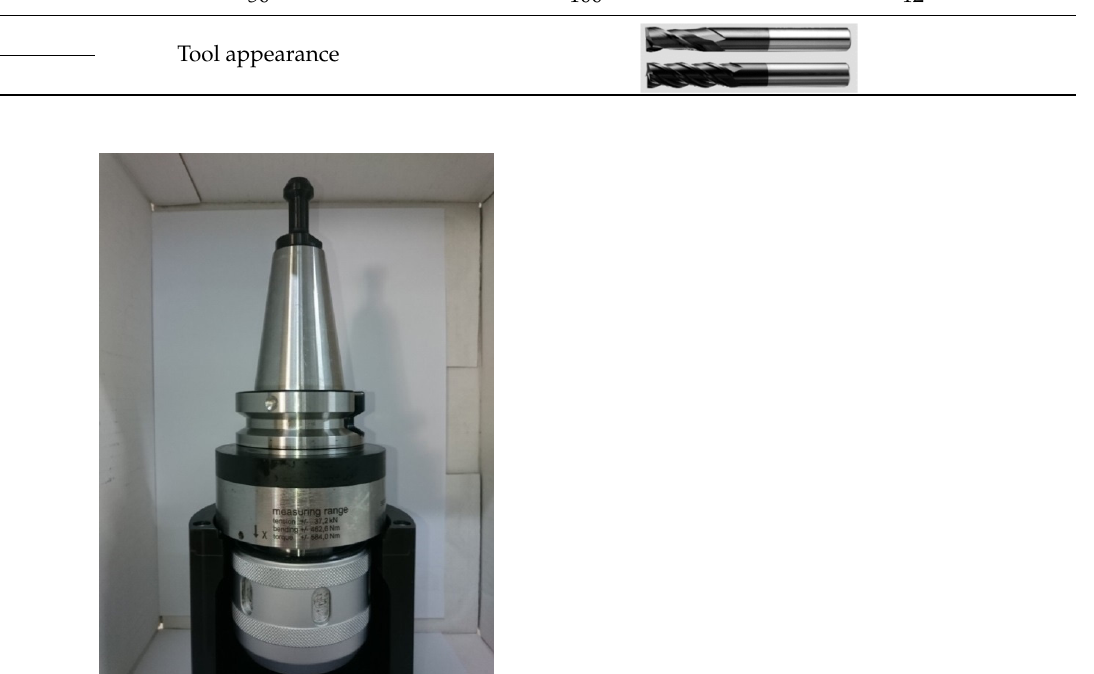
Figure 7. Tool holder embedded with sensors (Spike ® from Pro-micron GmbH). Table 2. Specifications of the tool holder.